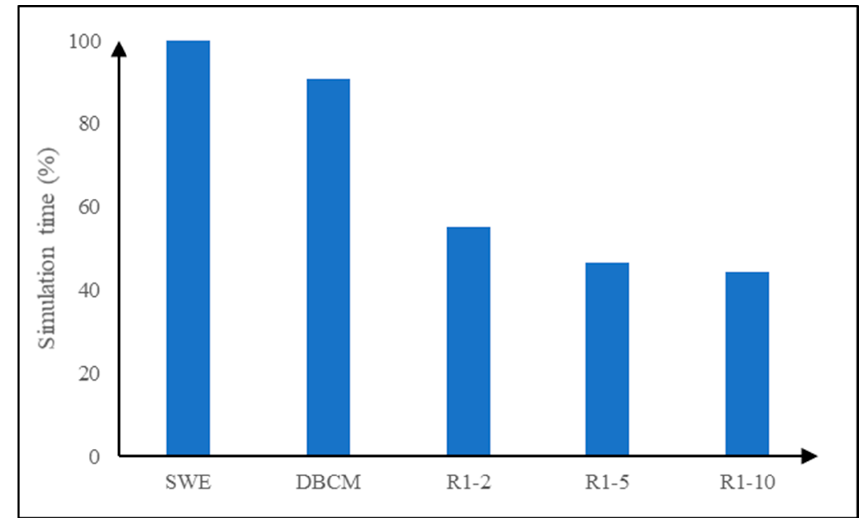
Figure 14. The simulation times of different models in different grid sizes. on the fine grid, and the computational domains of the SWEs and DWEs were able to switch dynamically. The location of the coupling boundary between these two algorithms at different times is shown in Figure 15, where the SWE zones are presented in yellow while the DWE regions are expressed in green. It can be clearly seen that the position of the coupling boundary was time-dependent. From Figure 15a, the water depth was high at 5400 s, when the accumulated rainfall reached the maximum, and the water depth in most areas was higher than the threshold. Therefore, most of the regions on the fine grid were defined as SWE regions. After 5400 s, when the rainfall stopped, the water depth began to decrease and became lower than the water depth threshold in most areas, leading to big DWE zones. Accordingly, from Figure 15b, the location of the coupling boundary moved to the SWE zones defined at the last moment, and the area of the SWE zones decreased. The results indicated that the coupling boundary was dynamic during the simulation, in accordance with the natural physical processes of flood formation and